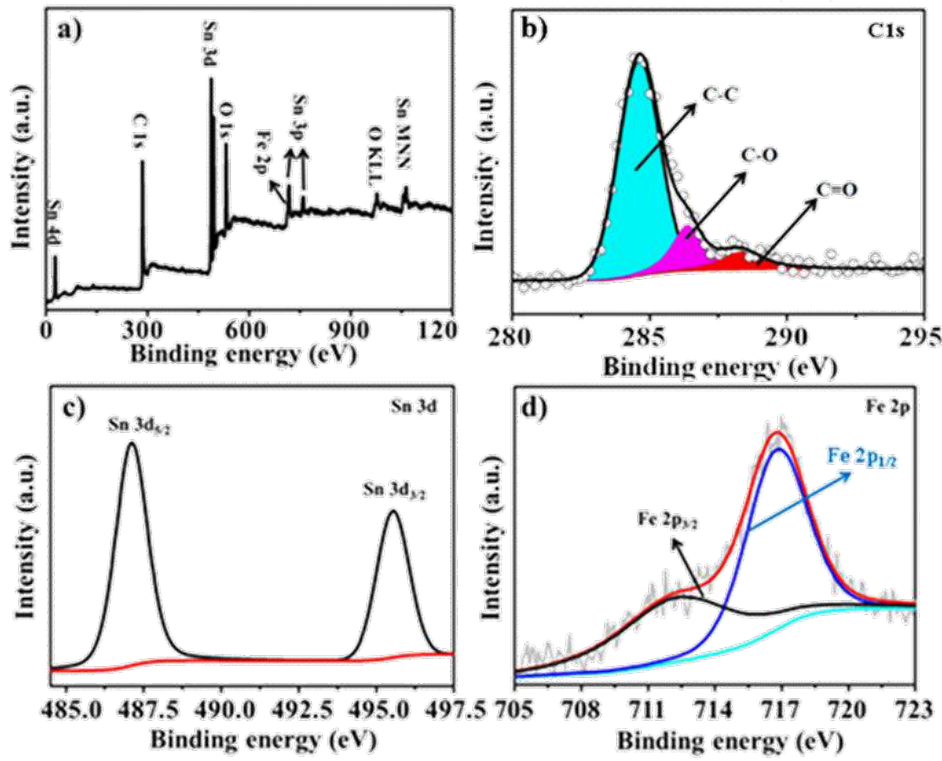
Figure 3. XPS spectra of SFO@C-400 sample: ( a ) survey spectrum, ( b ) C 1s, ( c ) Sn 3d, and ( d ) Fe 2p. 326